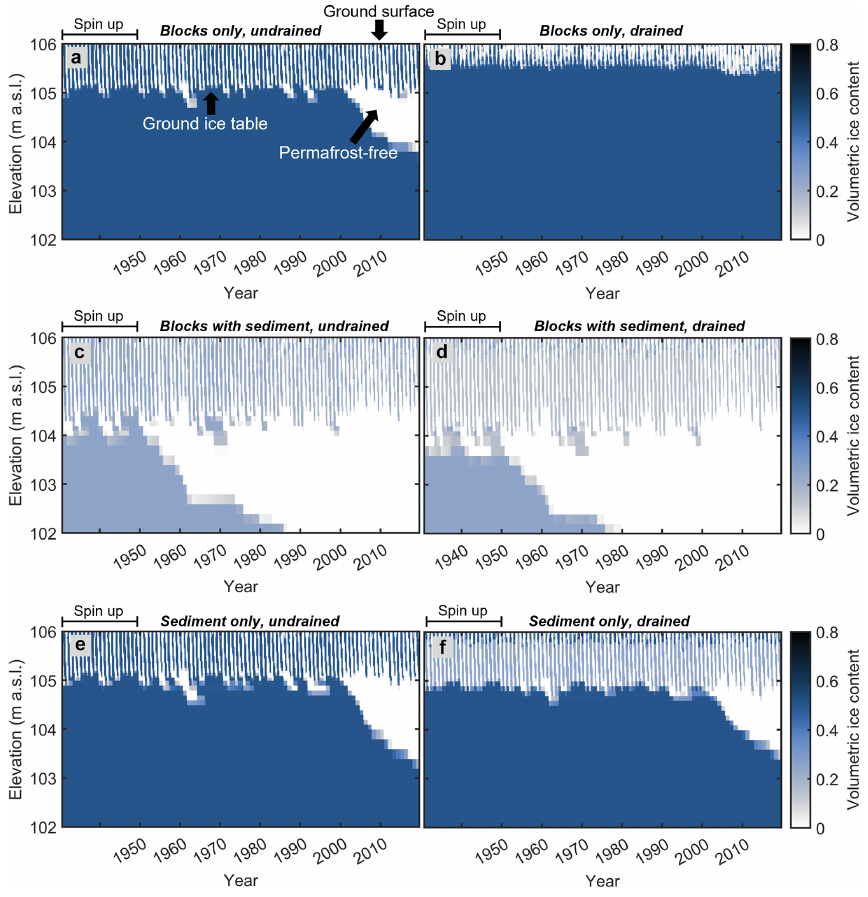
Figure 8. Modelled volumetric ground ice content at Ivarsfjorden between 1951 and 2019 for the idealized stratigraphies in undrained and drained conditions and sf = 1 . 0. Only the subsurface domain is shown, with the ground surface elevation at 106ma.s.l. In the active layer, ice contents increase and decrease annually, corresponding to the active layer refreezing and thawing. The ground ice table is defined as the uppermost cell where ground ice persists for more than 2 years and follows the permafrost